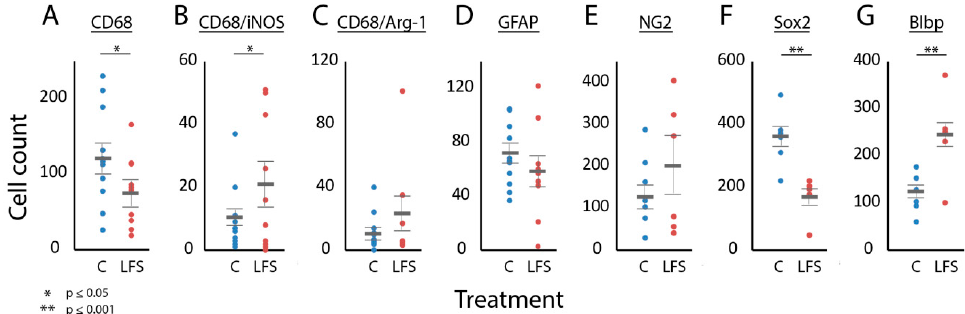
Figure 3. E ff ects of LFS of NRM on the expression of immune and neuroglial progenitor cell markers at the lesion. Scatter plots comparing cell counts for animals in the control (blue) and LFS (red) groups. Results are shown for CD68 ( A ), CD68 / iNOS ( B ), CD68 / Arg-1 ( C ), GFAP ( D ), NG2 ( E ), Sox2 ( F ), and Blbp ( G ). Only cell counts from DWM and GM are included. The thick horizontal gray bars show the mean of the counts. The thin horizontal gray bars show standard error. Asterixis above the graphs show statistical significance, if present, which was computed using bootstrap analyses. C, control; LFS, low-frequency stimulation.